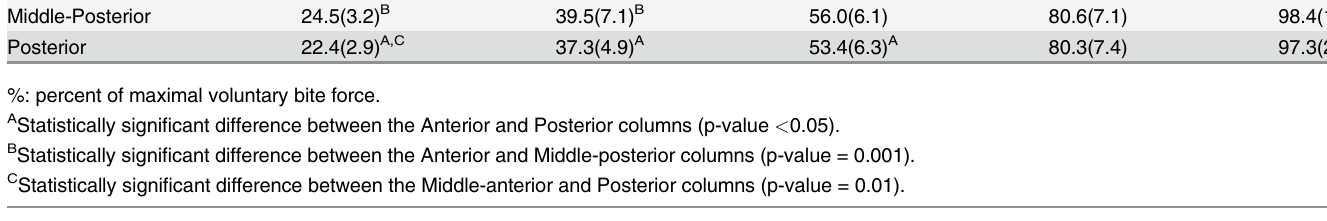
Table 1. Means and standard deviation of normalized electromyographic amplitude for four recording sites of the super fi cial masseter muscle during bites at different percentages of maximal voluntary bite force by healthy volunteers (n = 20). Columns 20% 40% 60% 80% 100% Anterior 29.5(5.6) A,B Middle-Anterior Middle-Posterior